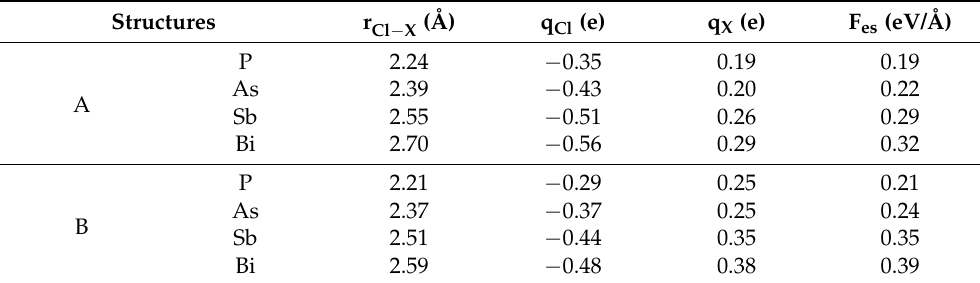
Figure 3. COHP analyses of the chemical bonding between the adsorbed chlorine and group-VA element for ( a ) α-phosphorene; ( b ) α-arsenene; ( c ) α-antimonene; ( d ) α-bismuthene; ( e ) β-phosphorene; ( f ) β-arsenene; ( g ) β-antimonene; and ( h ) β-bismuthene monolayers, with the adsorbed Cl atom. The bonding and antibonding states are positive and negative of −pCOHP, respectively. The corresponding integral of −pCOHP (−IpCOHP) values are also provided. Table 4. The bond lengths of Cl and group-VA atoms (r Cl−X ), Mulliken charges of the adsorbed Cl atom (q Cl ) and group-VA atoms (q X ), and electrostatic attractions (F es ) of all α- and β-monolayers with the adsorbed Cl.